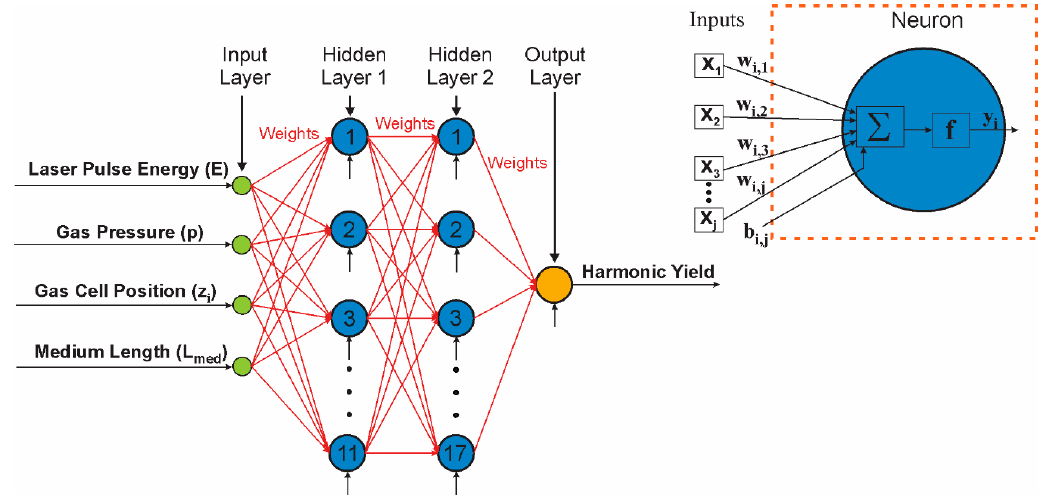
Figure 2. ANN architecture and the schematic representation of a neuron.